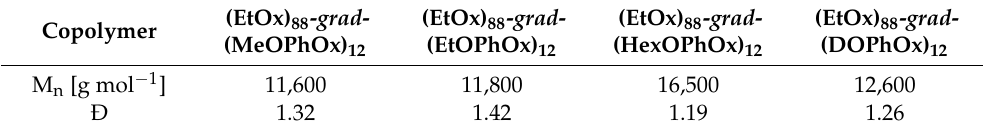
Table 1. Molecular characteristics of the used polymers. Ð is the dispersity.